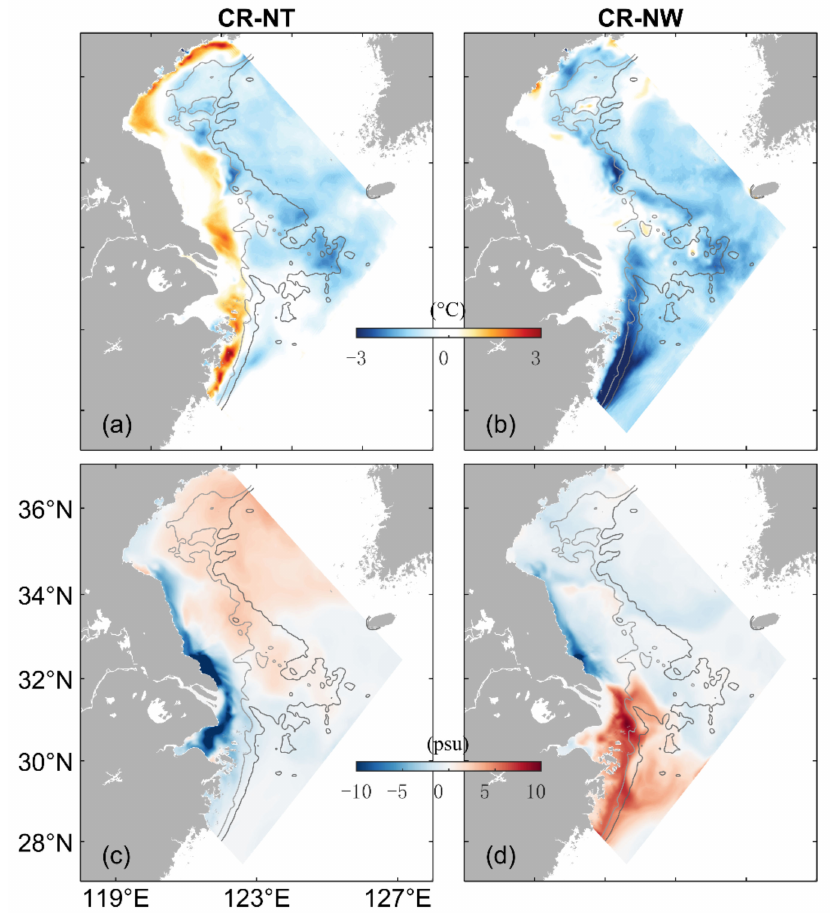
Figure 14. Differences in the simulated monthly mean SST ( a , b ) and SSS ( c , d ) between cases CR and NT ( a , c ) and between cases CR and NW ( b , d ) in August 2015. The light grey and dark grey contours are isobaths of 30 m and 50 m,